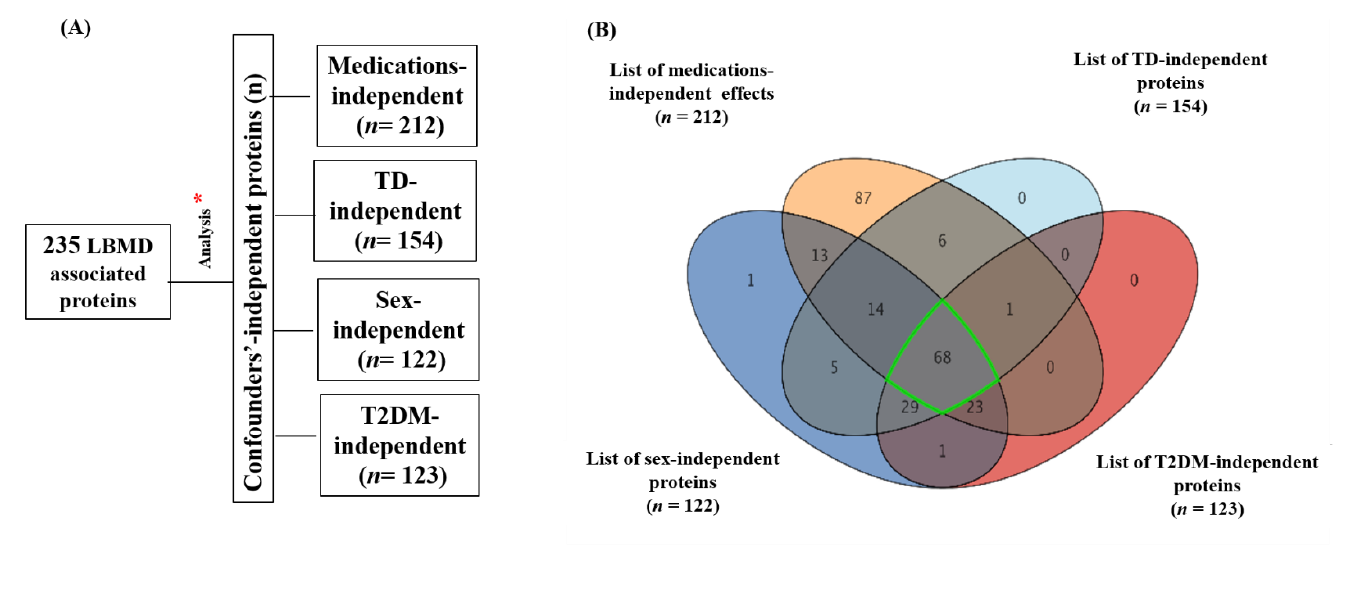
Figure 1. Overall proteomics analysis and exclusion of confounders-associated proteins. ( A ) Determination of confounder-independent proteins from the overall detected proteins. ( B ) Venn diagram demonstrating overlap between confounder-independent proteins (medications, TD, Sex, and T2DM) ( n = 212, 154, 122, and 123, respectively) using moderate t-test and considering fold change (FC 1.5) and cut-off p value < 0.05. A total of 68 proteins were identified as being significantly associated with LBMD, independent of the effect of confounders. Abbreviations: LBMD: low bone mineral density; TD: thyroid disease; T2DM: type 2 diabetes mellitus. * Two-way ANOVA with FDR-corrected p value (FDRp) cutoff = 0.05.